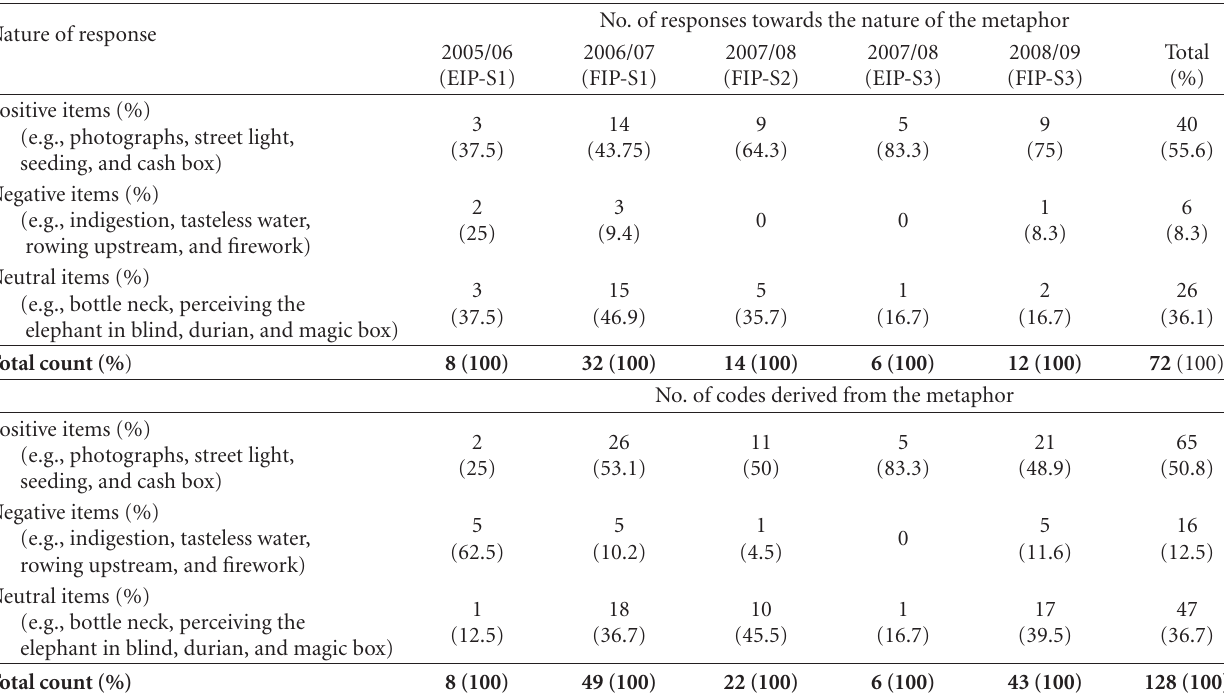
Table 4: Categorization of the metaphors used by instructors to describe the